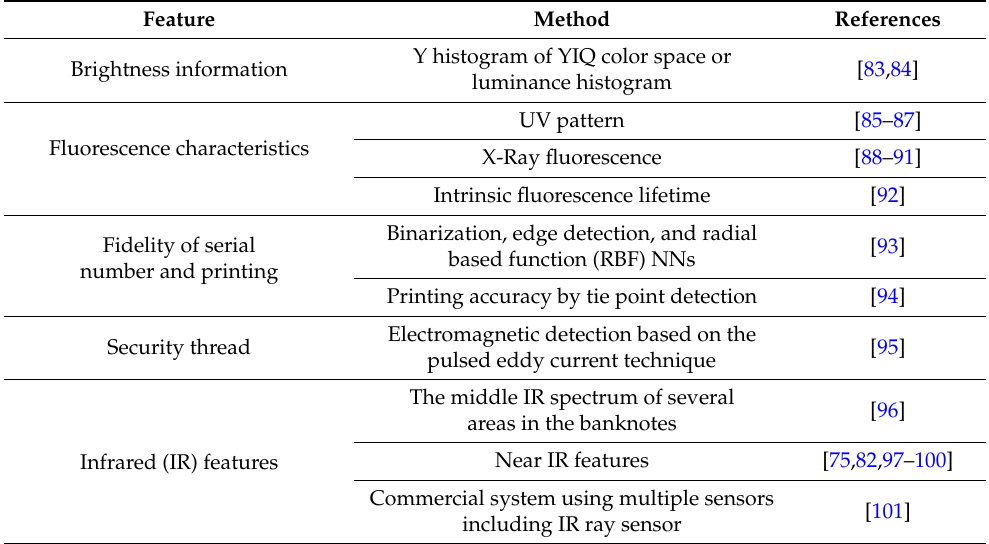
Table 6. Methods for identifying anti-counterfeiting features.